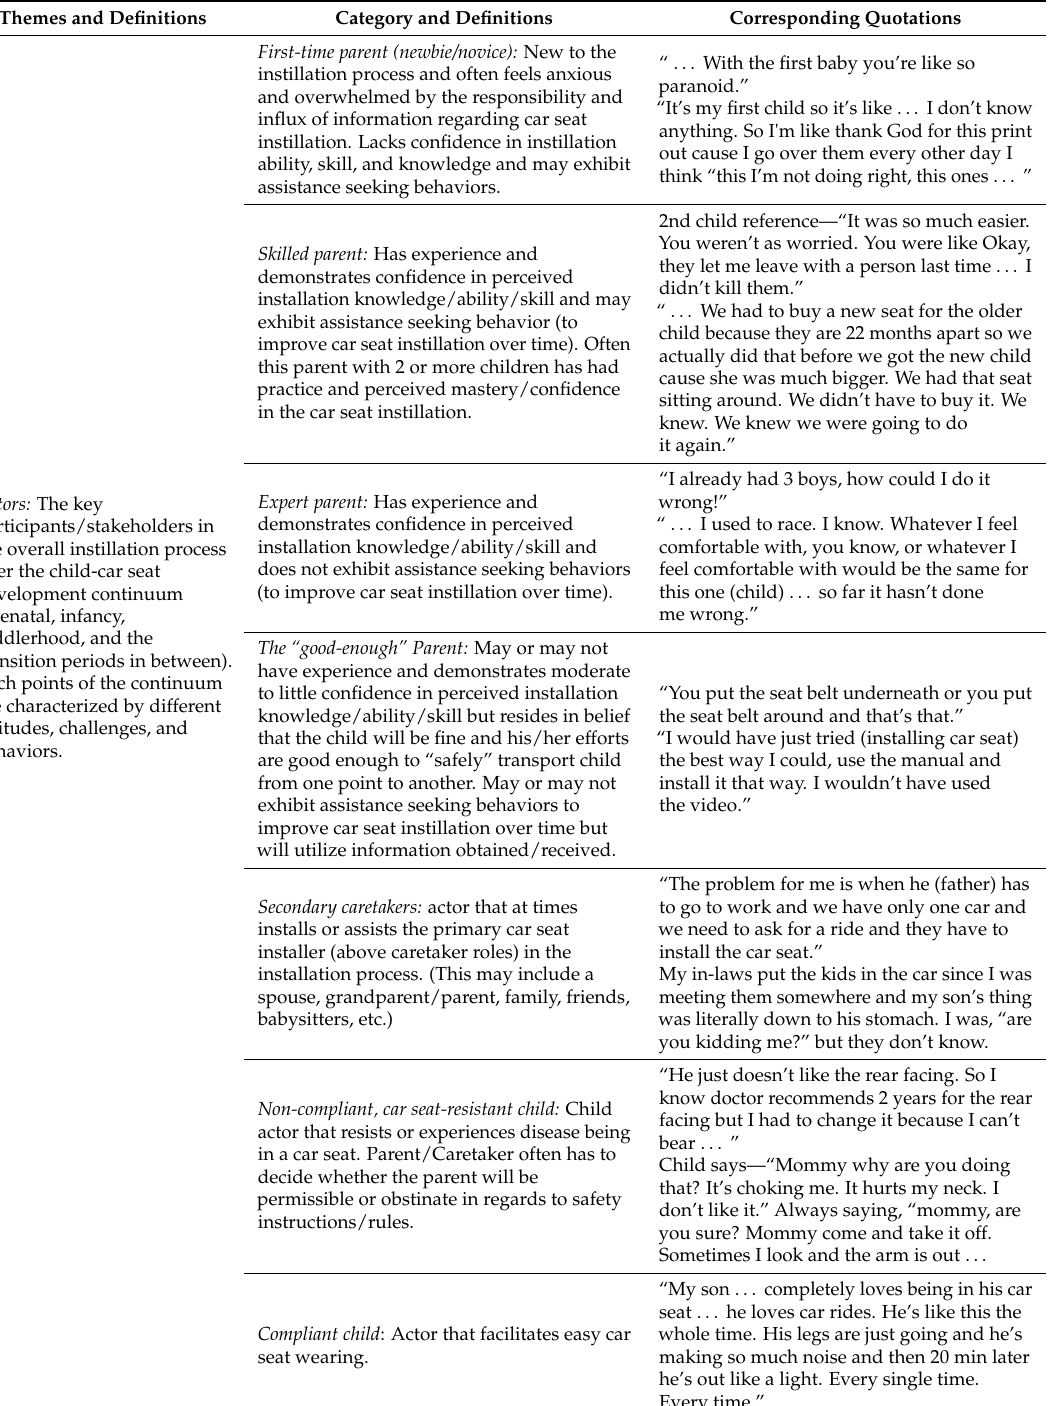
Table A1. Focus group themes and